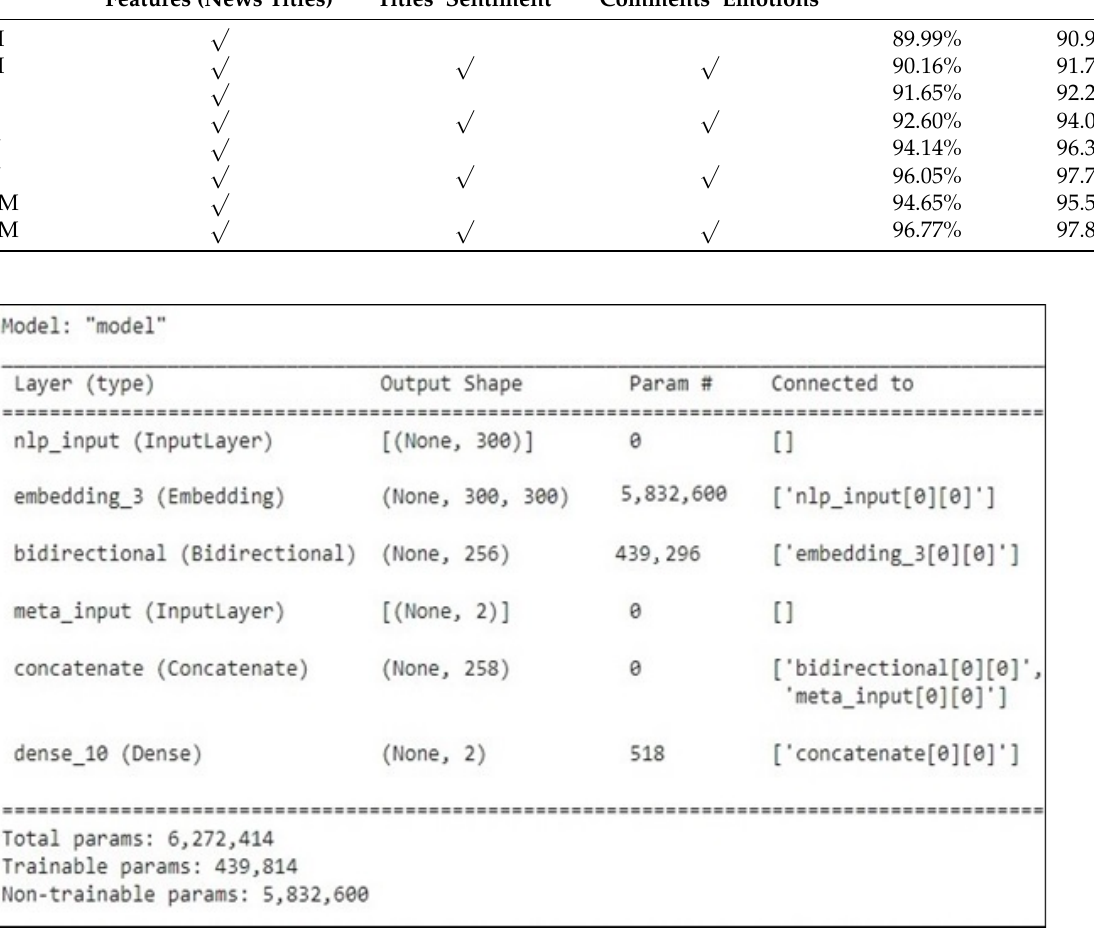
Figure 13. The configuration of the Bi-LSTM model.